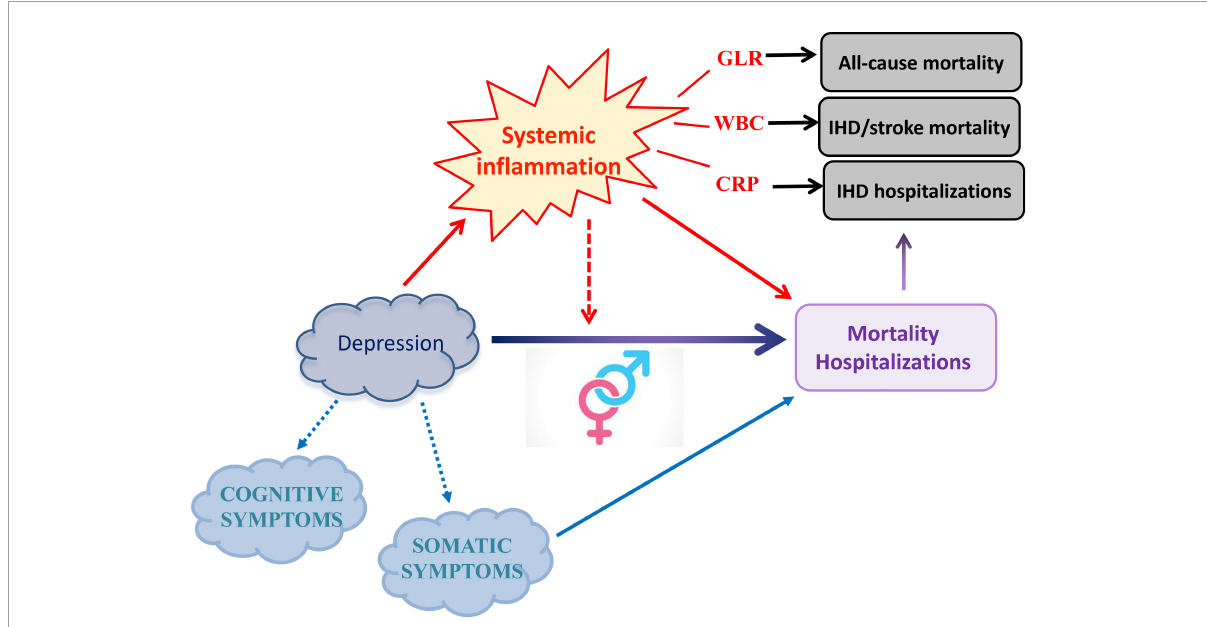
FIGURE1 Main hypothesis investigated and evidence observed in the present study. Here, we untangled the role of specific circulating inflammatory markers in the influence of depression severity on mortality and hospitalization risk, further elucidating differential associations within gender strata and with depressive symptom domains. Figure adapted from